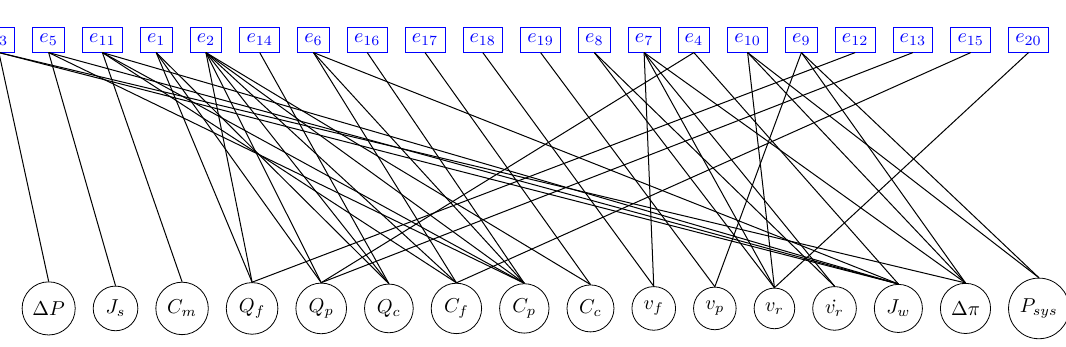
Figure 8. Bipartite graph of the RO desalination plant under